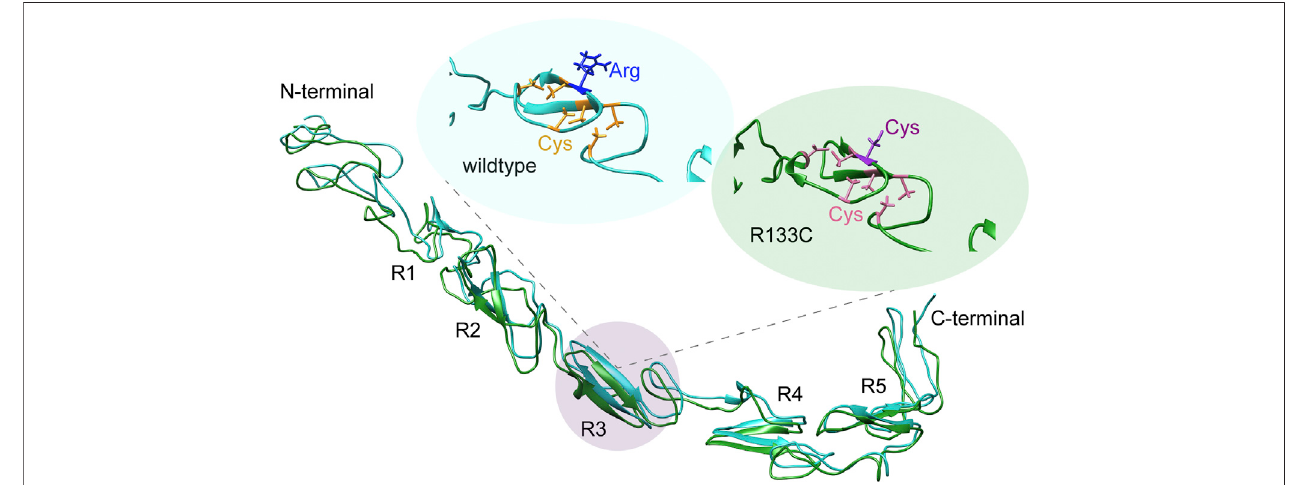
FIGURE2| StructuralanalysisofN3EGF 1 – 5 . (A) TertiarystructuremodelsofthewildtypeN3EGF 1 – 5 andR133CmutantmodelledbyI-TASSER,whileC-scoresof the modelling are − 0.23 and − 2.14, respectively. EGF repeats are labeled with R1, R2, R3, R4, and R5. The Cys residues in the WT N3 EGF 1 – 5 and R133C mutant are shown in yellow (B) and pink (C) , respectively. The position of wildtype R133 and mutation C133 is in blue and purple, respectively.